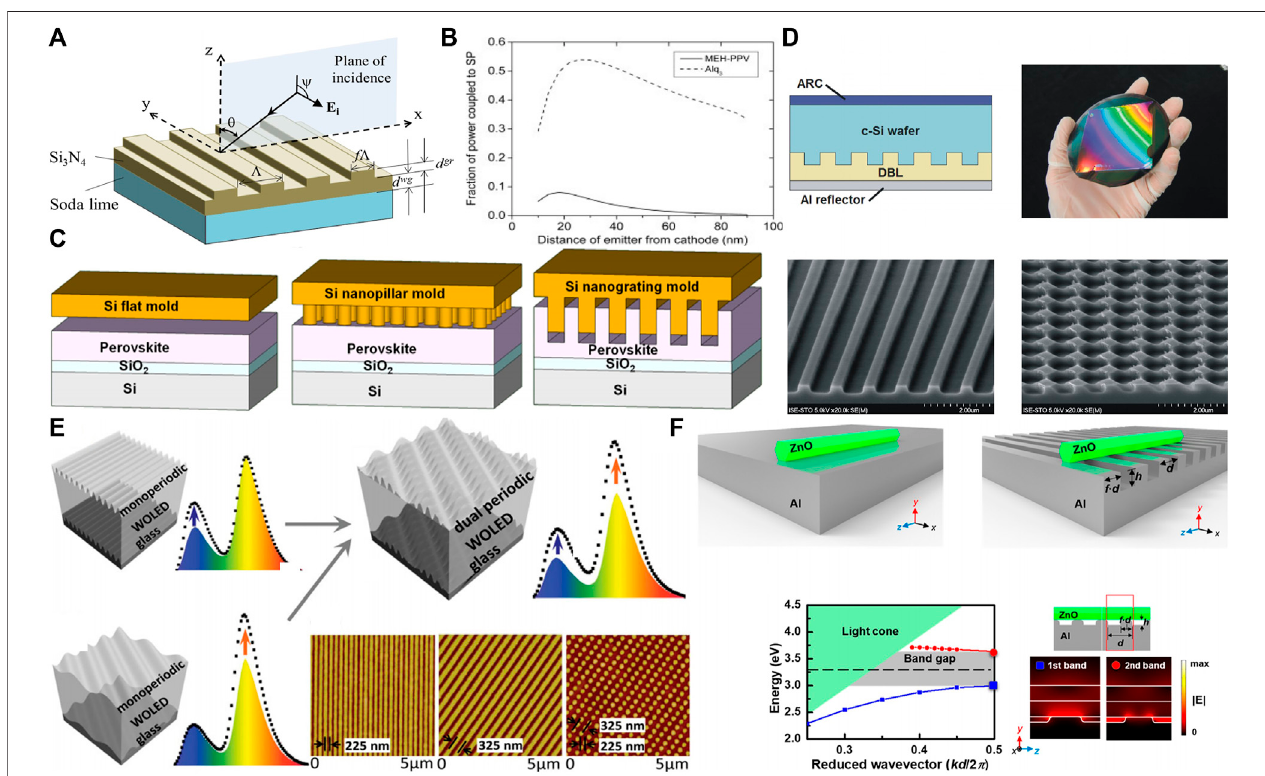
FIGURE1| Thegratingstructuresinoptoelectronicdevices, (A) GMR fi lterwithgratingstructure. (B) Thecalculatedfractionofpowerlostfromradiativeexcitonsto surface plasmon modes is shown as a function of position of the exciton within the organic layer. (C) . Schematic of nanoimprint lithography process with different Si molds. (D) The schematic diagram, photograph and SEM of the grating structures in solar cell. (E) Schematic of the broadband light extraction using OLED with dual- periodicgratingstructuresandthemorphologiesofaseriousofgratingstructures. (F) Schematicrepresentationandcharacteristicsofsurfaceplasmonwaveguide and periodic grating structures. Reproduced from Cunningham et al. (2011) with permission of Optical Society of America. Reproduced from Barnes et al. (2002) with permission of WILEY. Reproduced from Hu et al. (2016) with permission of American Chemical Society. Reproduced from Mellor et al. (2013) with permission of Optical Society of America. Reproduced from Sun et al. (2013) with permission of WILEY. Reproduced from Lin et al. (2018) with permission of American Chemical Society.